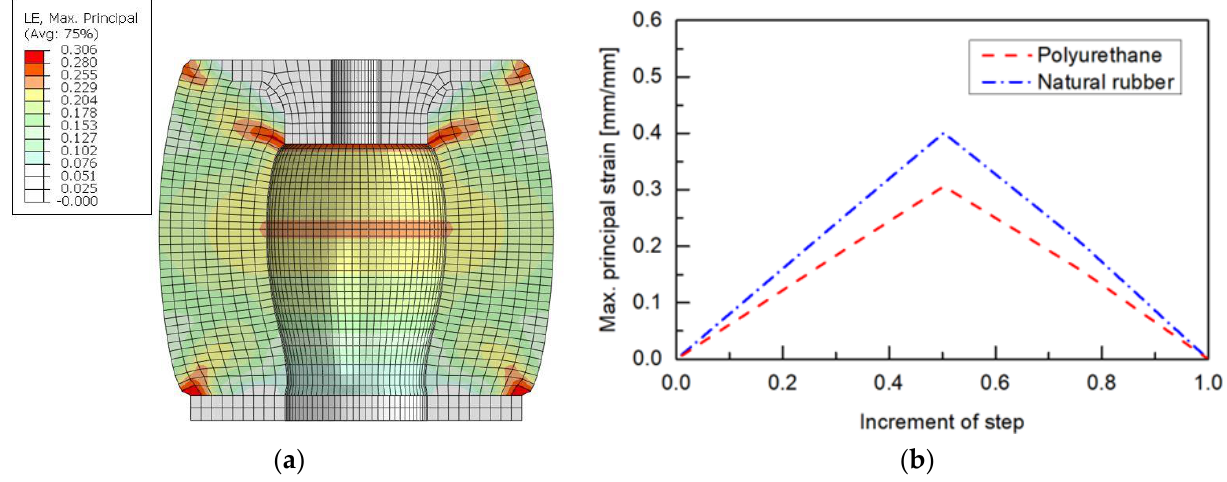
Figure 10. MPS distribution and histories of the original shape (shape 6 in Figure 4): ( a ) NFEA results; ( b ) comparison of MPS history between natural rubber and polyurethane.